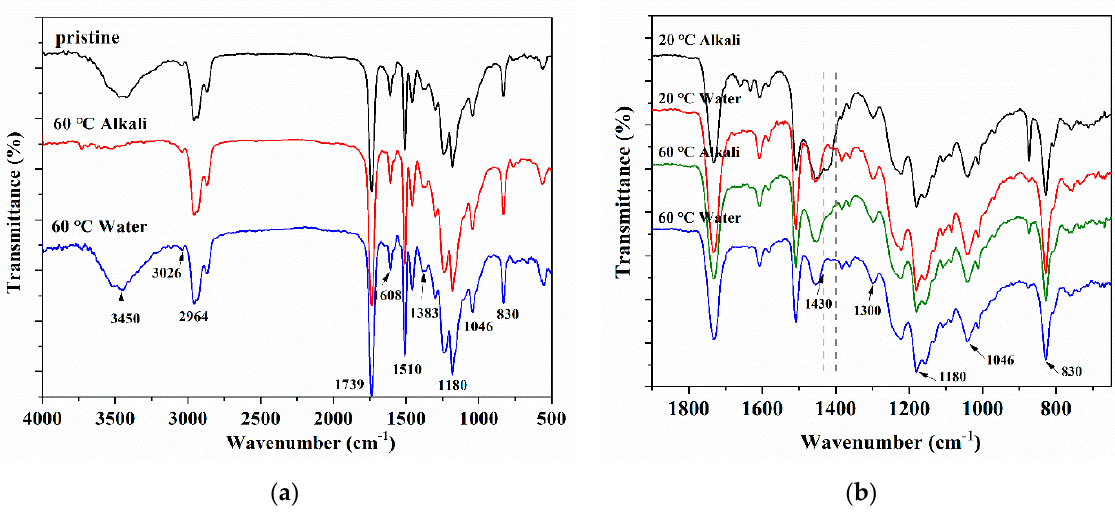
Figure 5. Water uptake characteristics of epoxy resin specimens immersed in distilled water or the alkali solution at 20 °C and 60 °C.